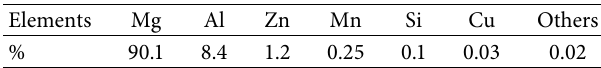
Table 1: Element identification of the collected sample using an XRF spectrometer.